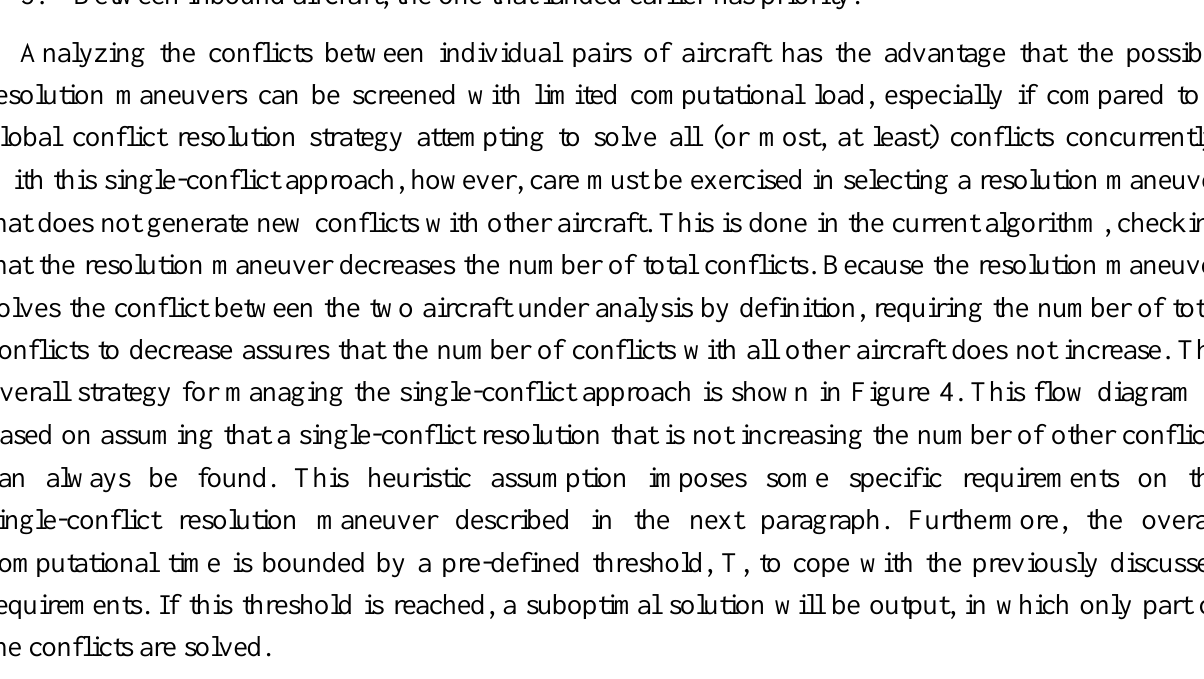
Figure 4. Managing the single-conflict